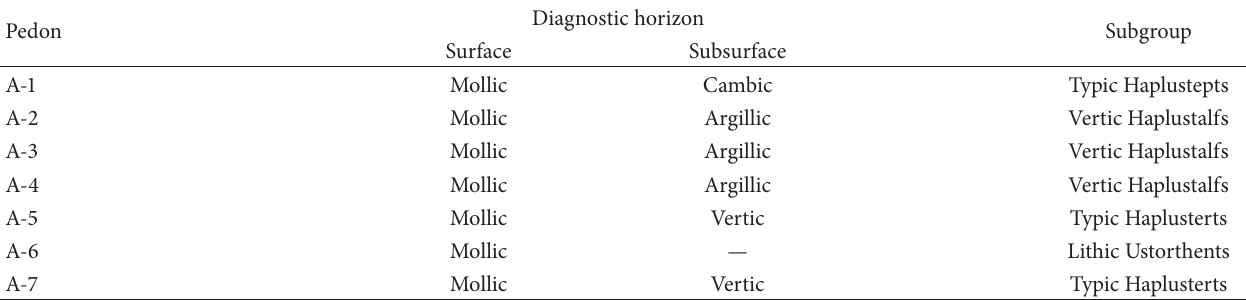
Table 12: Diagnostic horizons and soil types of Abobo area according to Soil